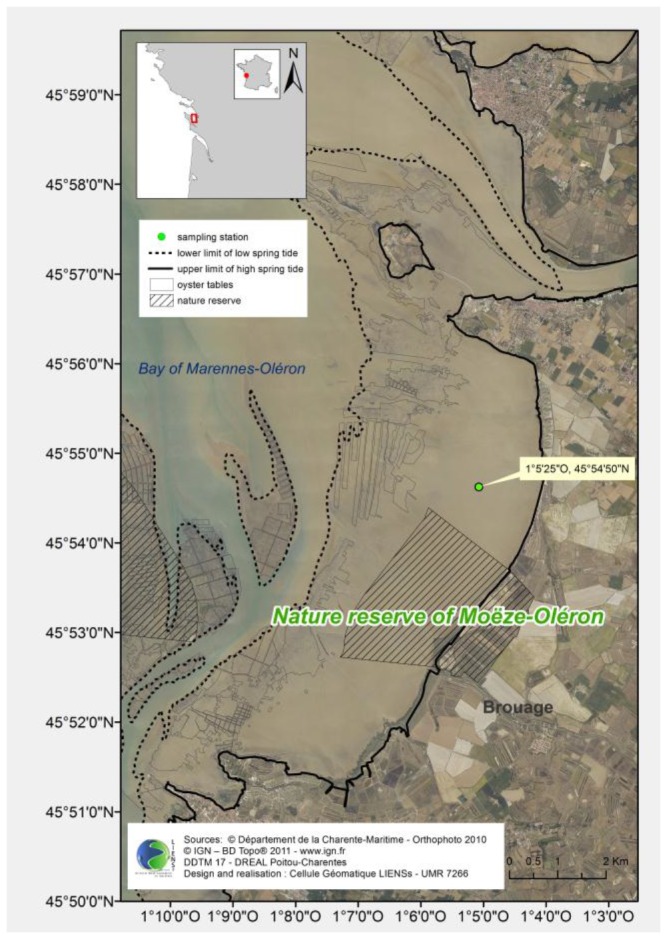
Study site the Brouage mudflat that includes a part of the nature reserve of Moëze-Oléron.Published with permission under a CC-BY license.